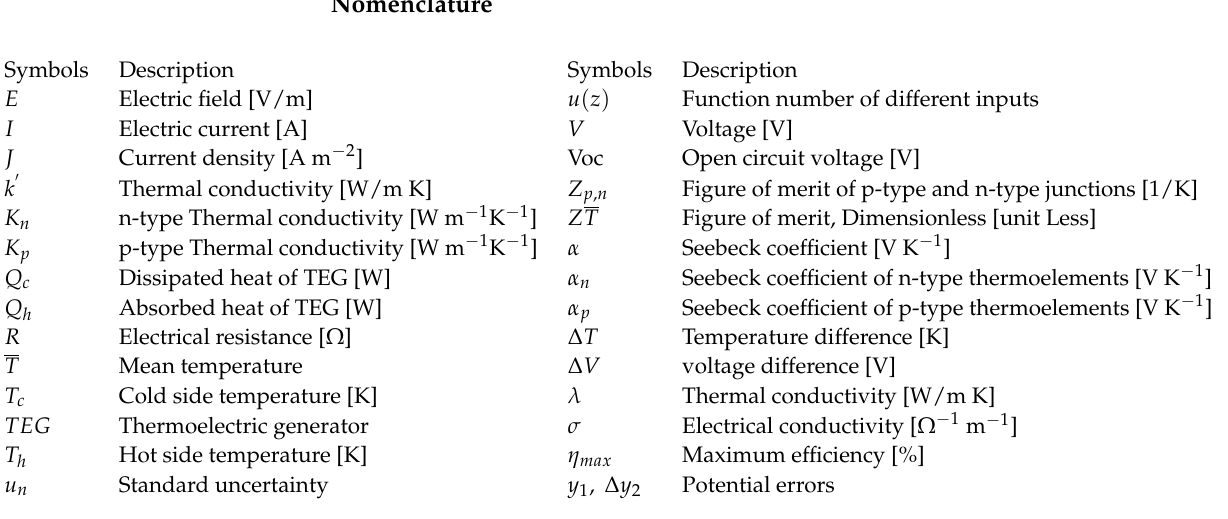
Figure of merit of p-type and n-type junctions [1/K] Figure of merit, Dimensionless [unit